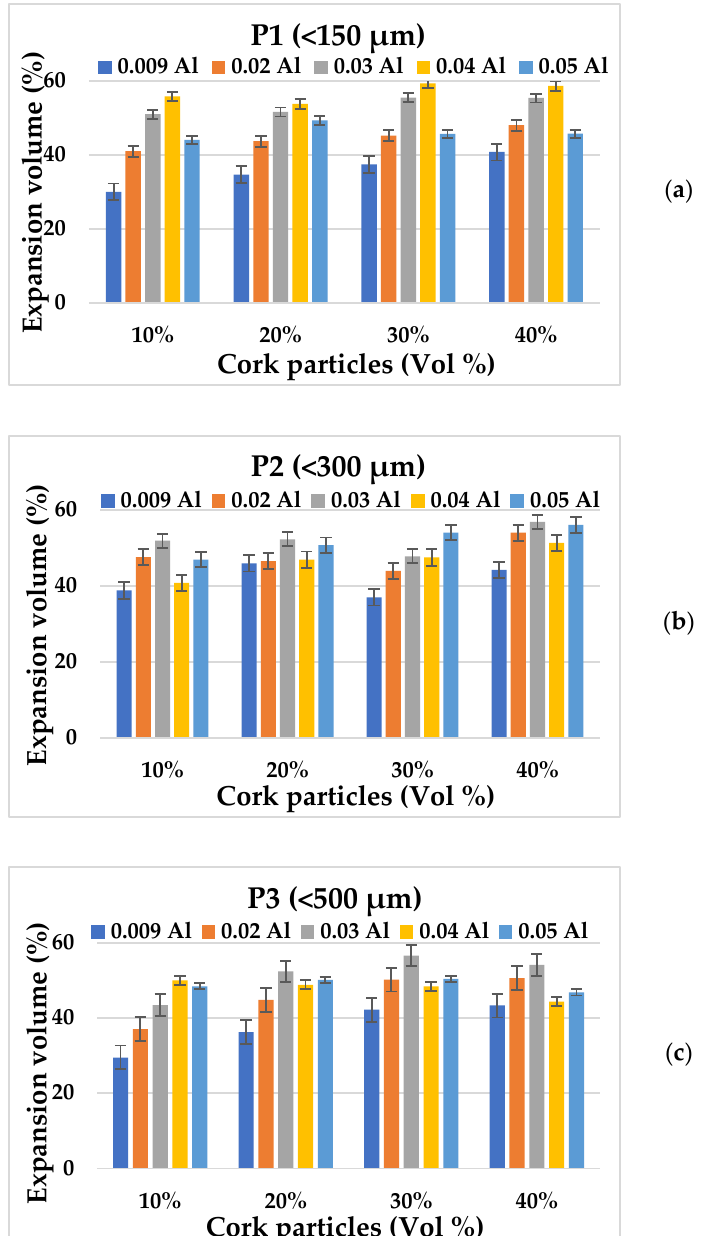
Figure 5. Expansion volume versus cork particles using different amount of Al powder; ( a ) P1 (<150 µm), ( b ) P2 (<300 µm), and ( c ) P3 (<500 µm).